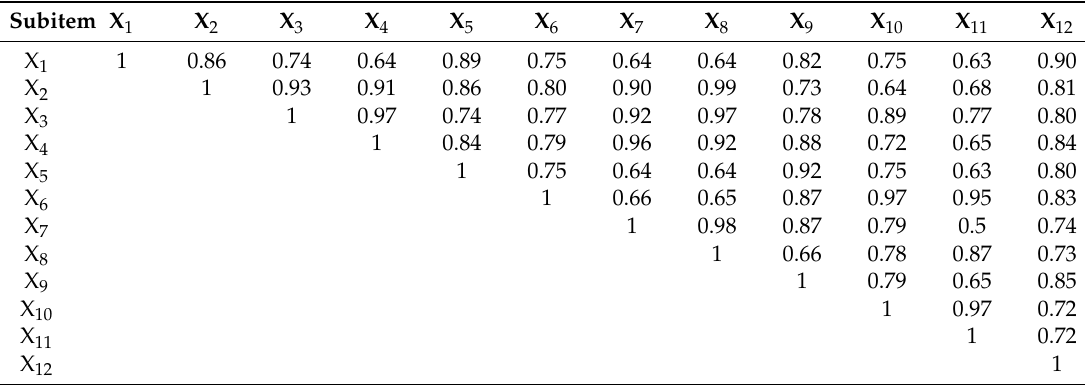
Table 4. The upper triangular matrix for the Level 2 indices.